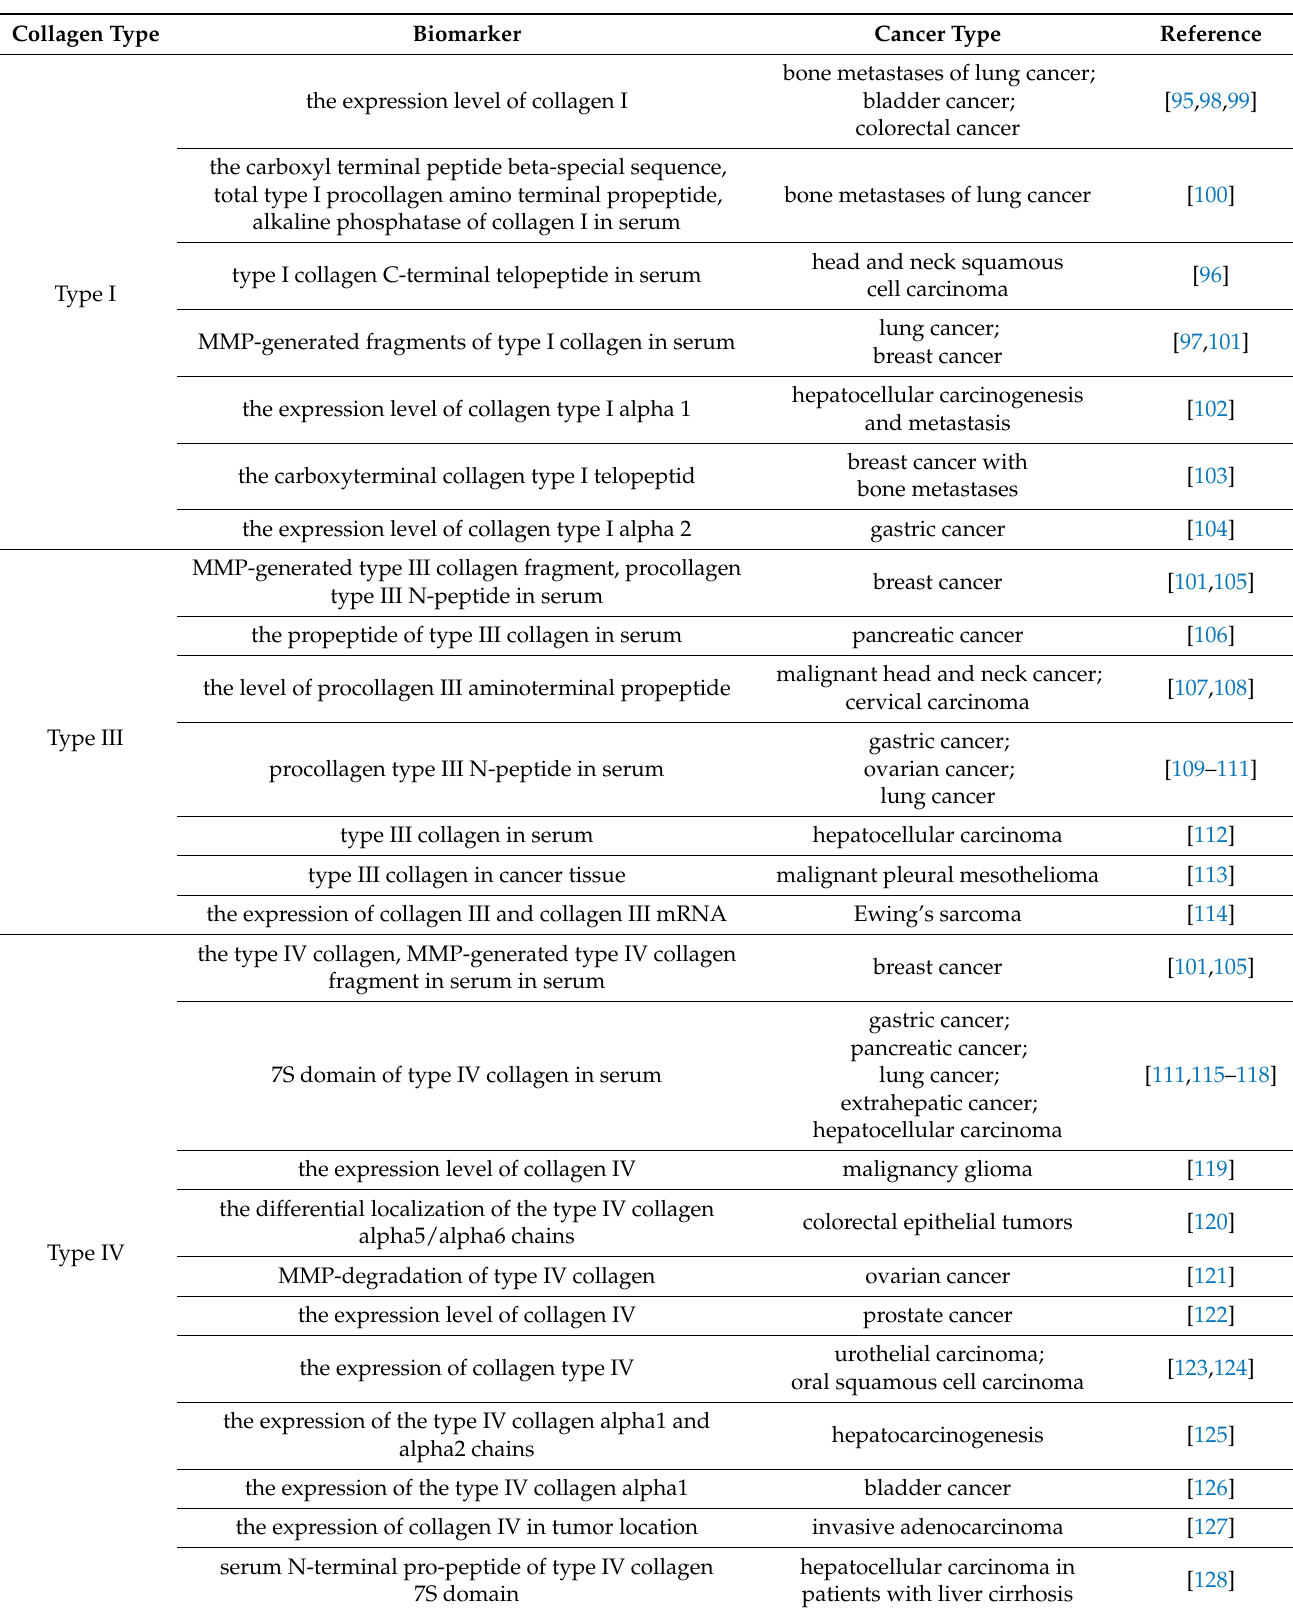
Table 1. The collagen-associated biomarkers and the applicating cancer types in cancer